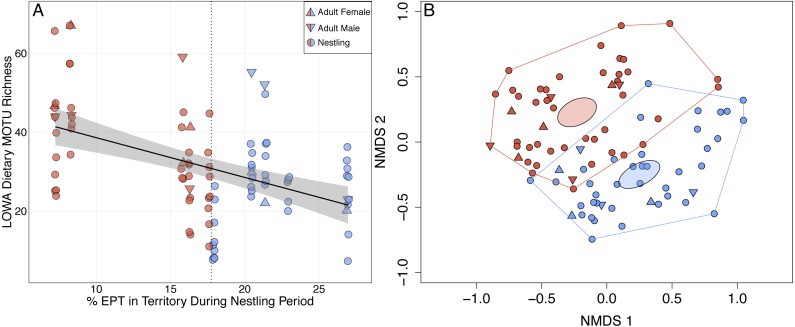
Shifts in adult and nestling Louisiana Waterthrush (LOWA) diet in response to reduced availability of EPT taxa during the period of nestling care.(A) MOTU richness of adult (females, triangles; males, inverted triangles) and nestling (circles) diets increased significantly as percent EPT declined (\documentclass[12pt]{minimal}
\usepackage{amsmath}
\usepackage{wasysym}
\usepackage{amsfonts}
\usepackage{amssymb}
\usepackage{amsbsy}
\usepackage{upgreek}
\usepackage{mathrsfs}
\setlength{\oddsidemargin}{-69pt}
\begin{document}
}{}${X}_{4,5}^{2}=4.97$\end{document}X4,52=4.97; P = 0.026). Point shading indicates whether a fecal sample was collected from a territory with a percent EPT ≤ (red) or > (blue) the median value of 17.7 (vertical dotted line). Gray shading represents the 95% confidence interval. (B) Unconstrained NMDS ordination (stress = 0.260) of adult (females, triangles; males, inverted triangles) and nestling (circles) diet composition at the MOTU level. Points represent the taxonomic composition of individual diets and shading indicates that the individual occupied a territory with a percent EPT ≤ (red) or > (blue) the median value of 17.7. Ellipses represent 95% confidence intervals (based on standard error) for group centroids and minimum convex polygons indicate the extent of dietary niche space for each group.